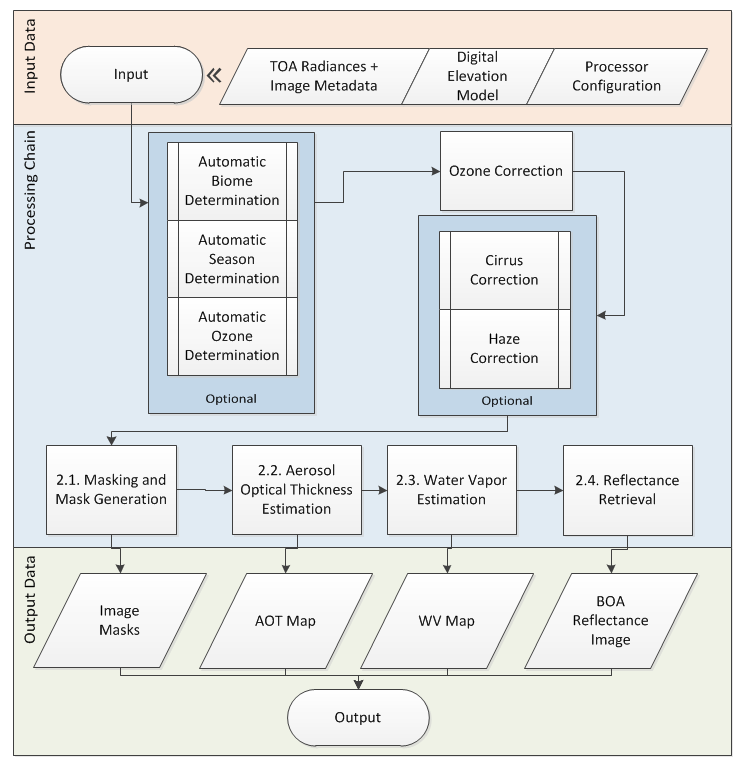
Figure 1. PACO algorithm workflow. The upper and bottom rows contain the input and output products, respectively. In the central row (blue box), the workflow of the algorithms described